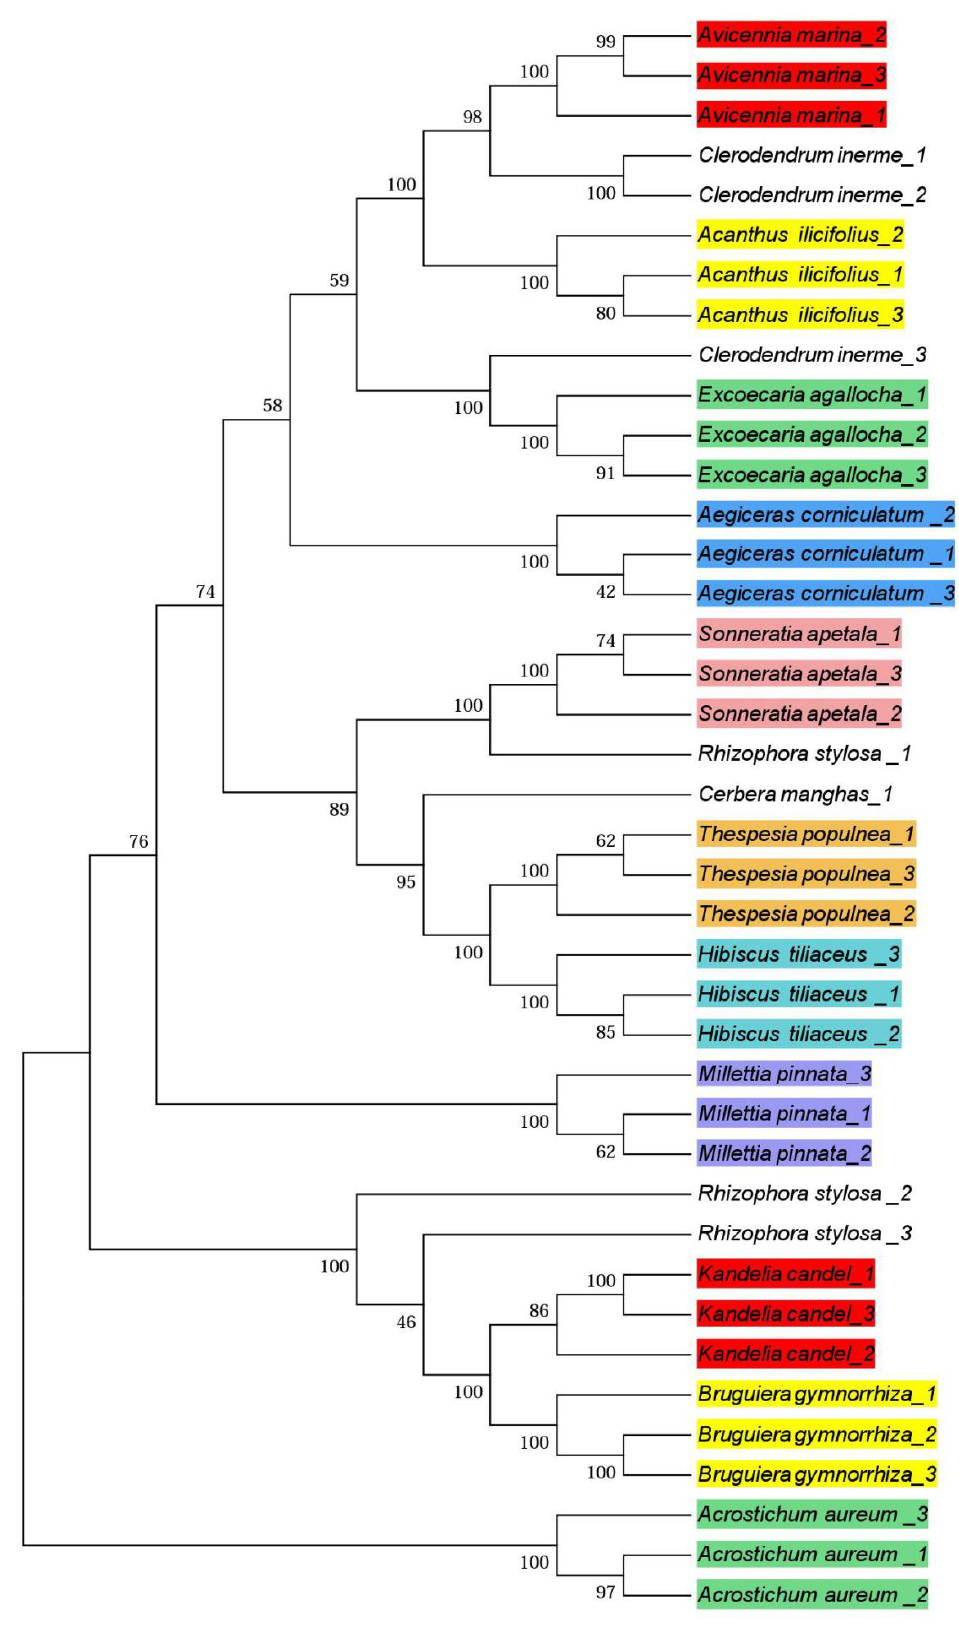
Figure 4. The phylogenetic tree of mangroves in Huizhou using fragment of matK + rbcL + trnH-psbA + ITS.